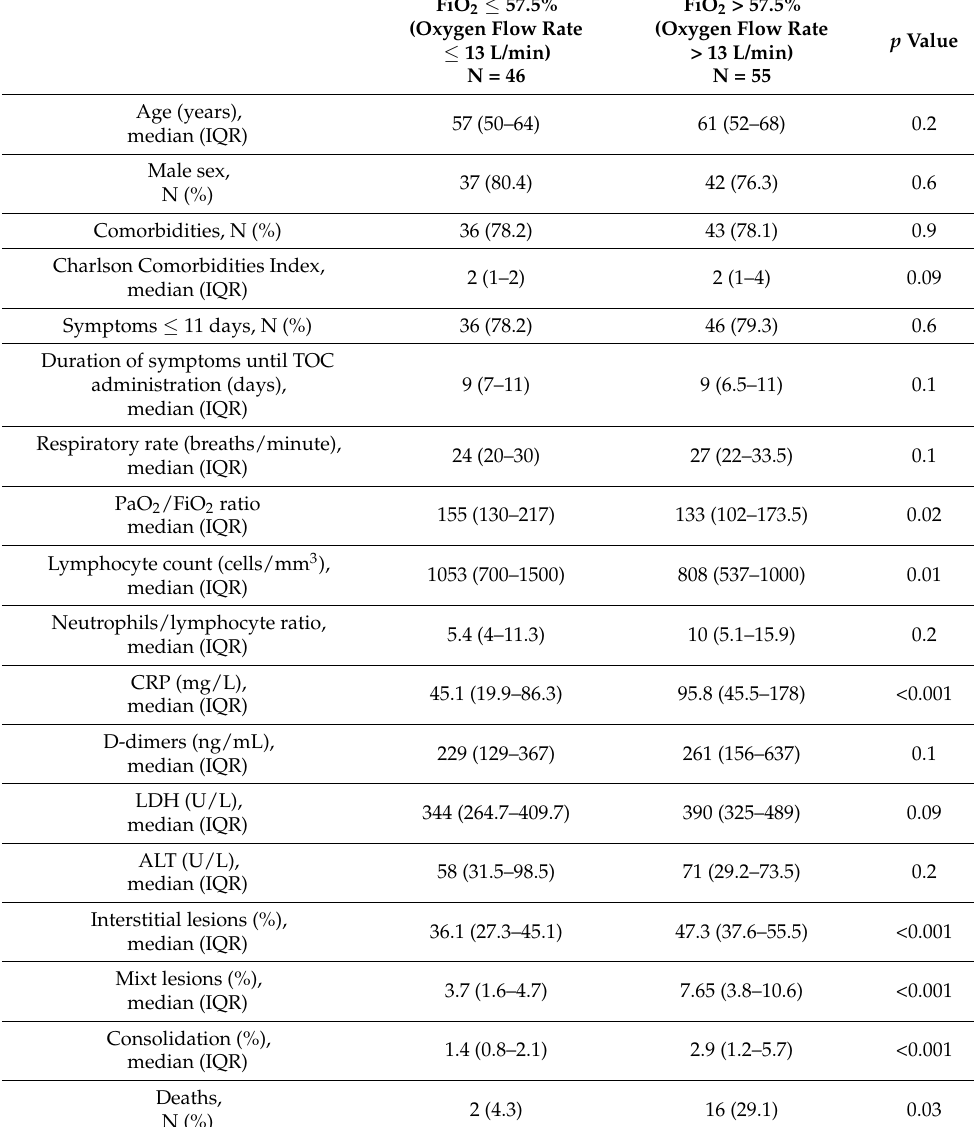
Table 3. Comparative analysis according to the oxygen flow rate and FiO 2 at TOC